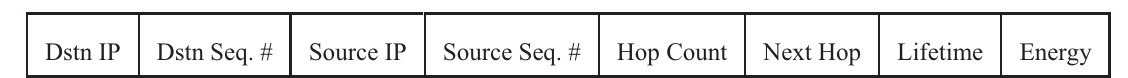
Figure 3. Proposed RREQ message